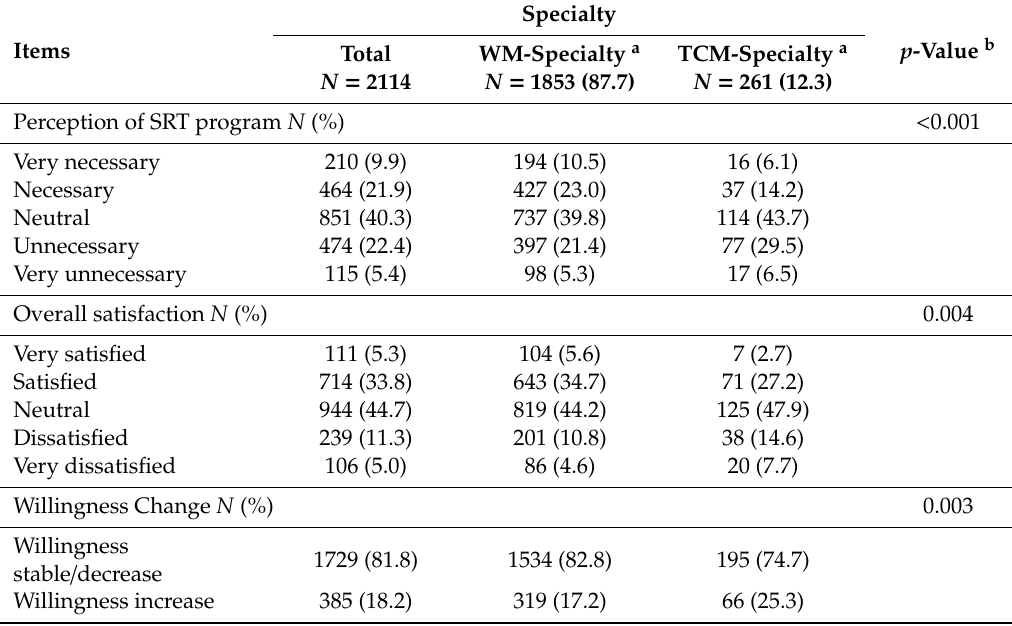
Table 3. Trainees’ perception of, overall satisfaction toward the SRT program, and change in willingness to become a doctor after the exposure to SRT program ( N =